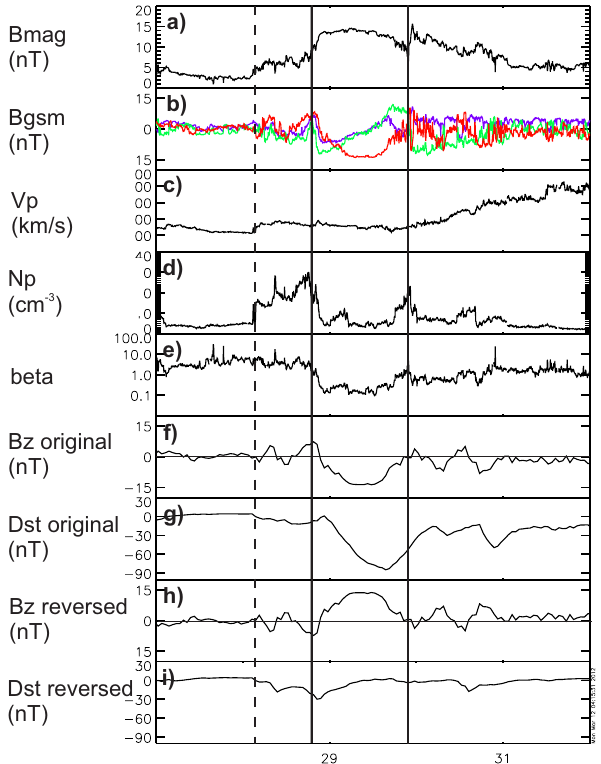
Fig. 5. Example of an unipolar magnetic cloud detected on 28– 29 May 2010. The panels are same as in Fig.